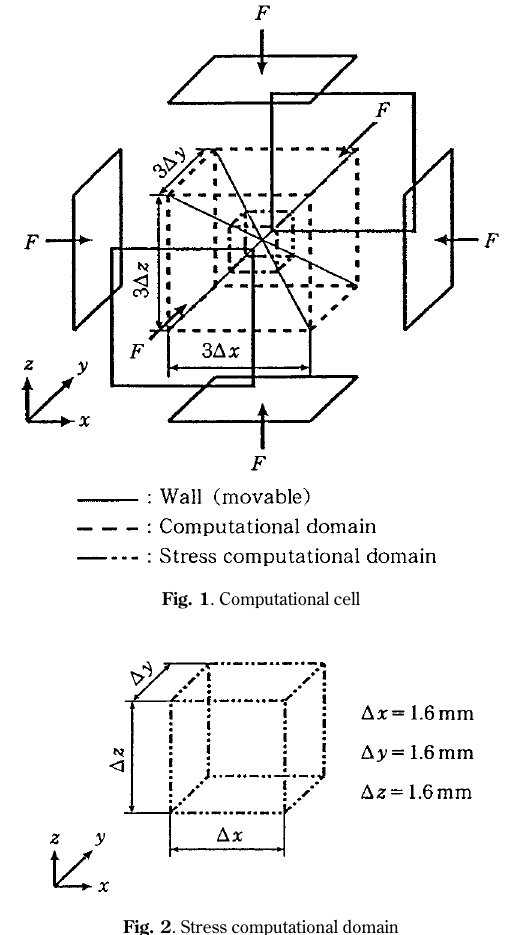
Fig. 2 . Stress computational